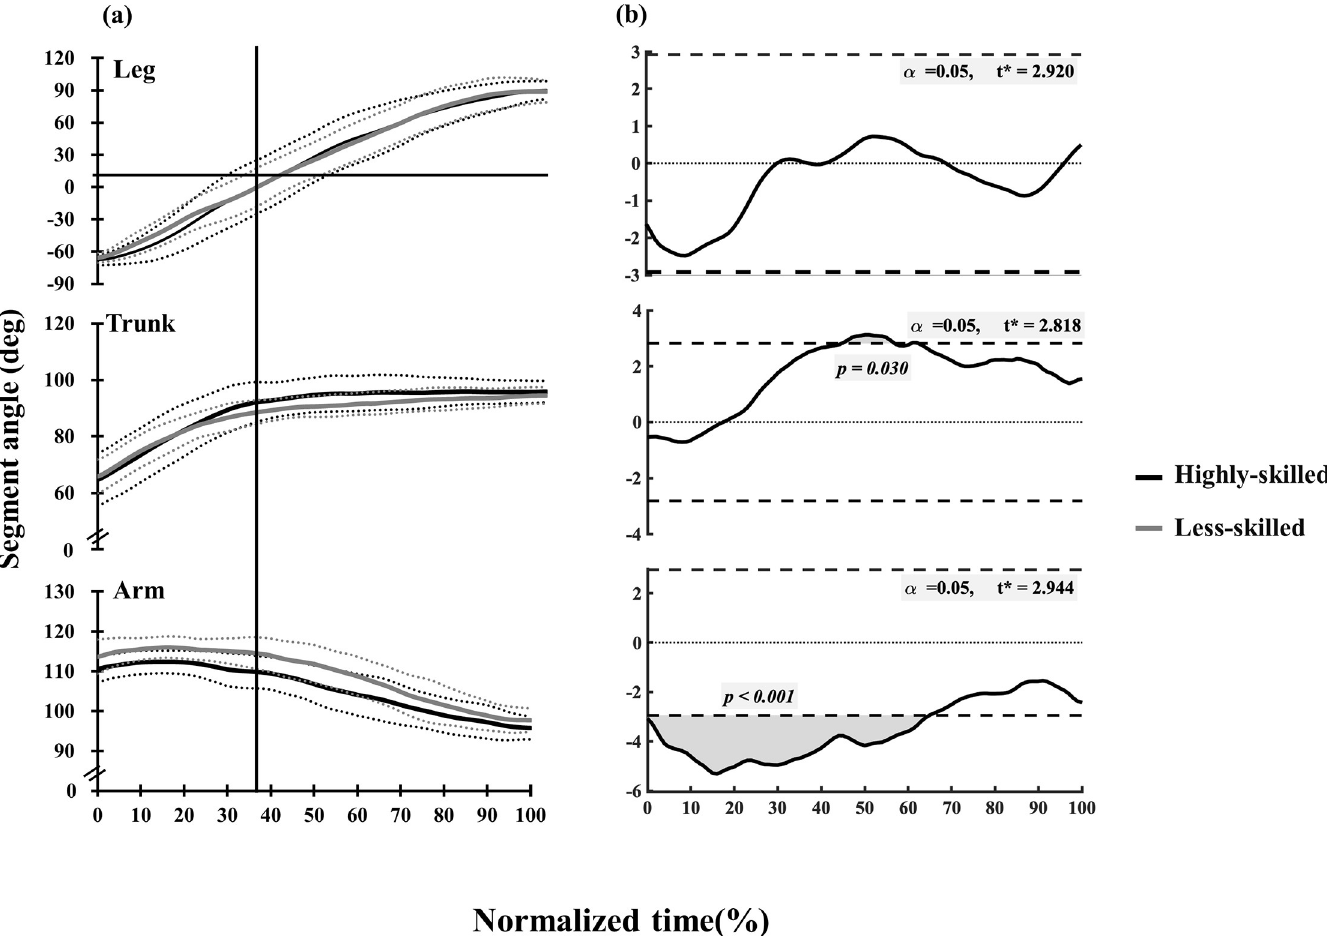
Fig 5. Changes in mean values of segment angles (a) and statistical parametric mapping (SPM) (b) between highly-skilled and less-skilled. Horizontal axis indicated normalized time of SAPH defined as 100% from Toe-off to Handstand. Dotted lines indicated mean ± one SD. Vertical line indicated the timing of Leg horizontal position. Associated SPM t-test results for differences between the curves in (b). The shaded area indicates suprathreshold clusters, which correspond to statistically significant differences between the curves at those nodes (percentage of normalized time). Asterisks indicated time zones when significant differences ( p < 0.05) between highly-skilled and less-skilled were